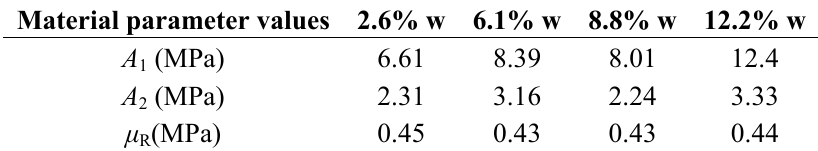
Table 1. Material parameter values of A of MWCNTs.